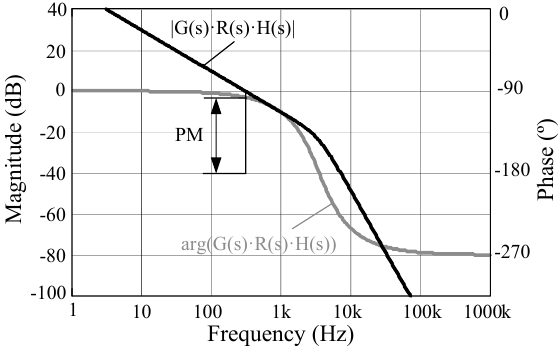
from the control action, U L . D UM